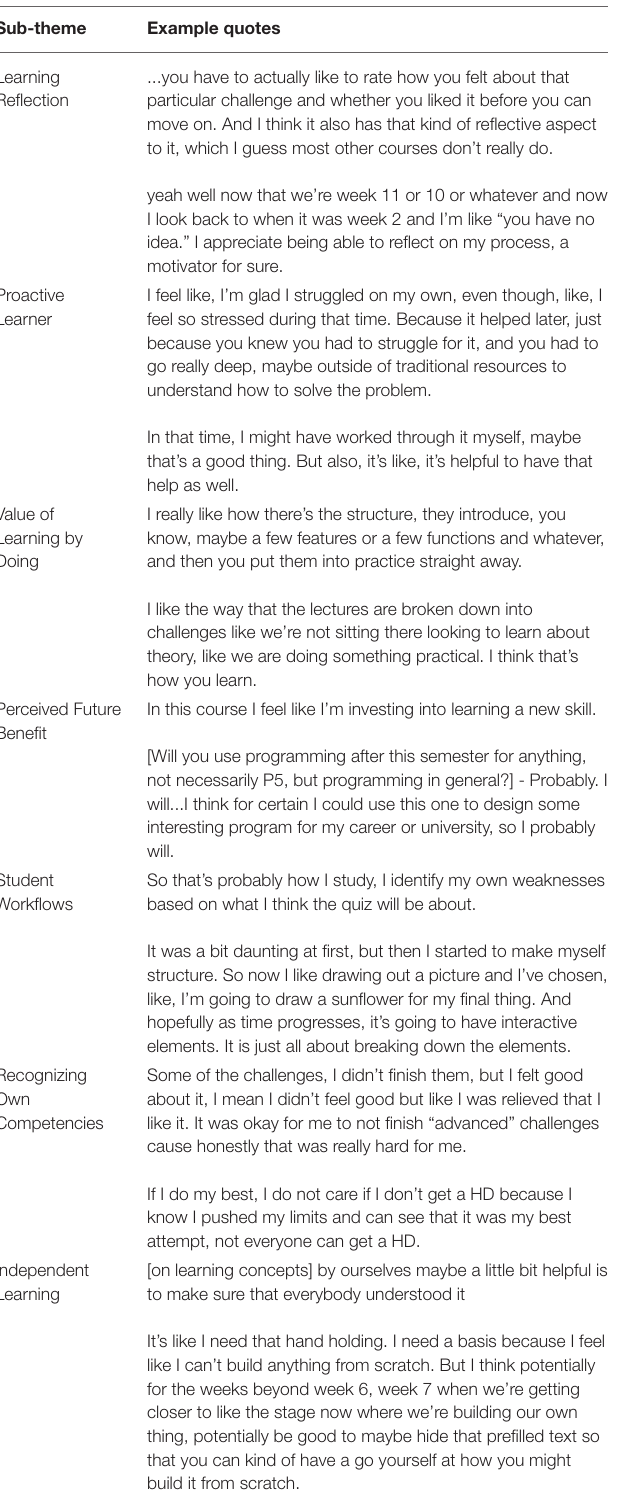
TABLE 1 | Sub-themes within the “Learning as a Skill” theme. TABLE 2 | Sub-themes within the “Learner Technology”